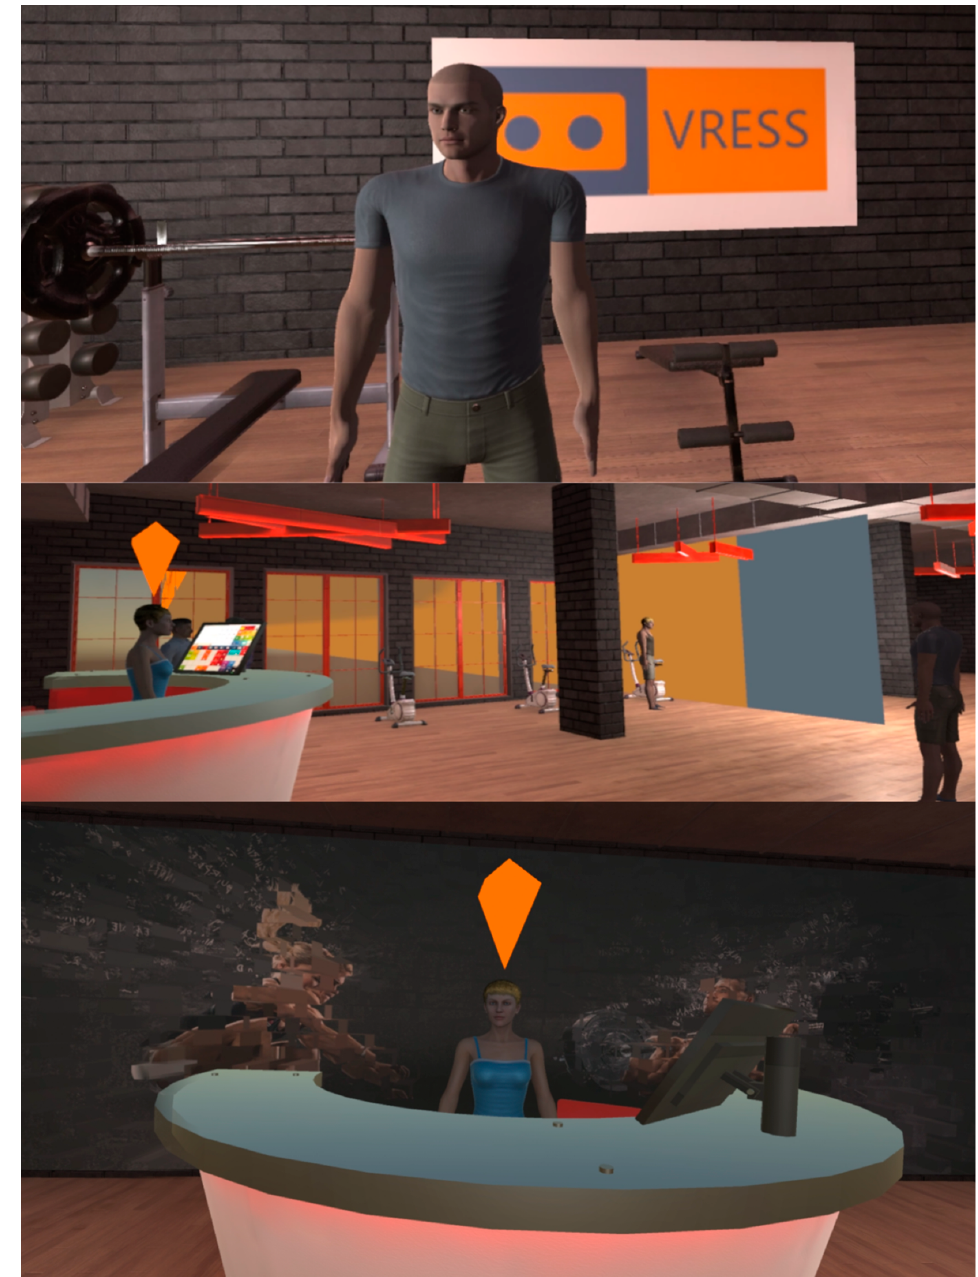
Figure 3. The instructor ( Top ), main area ( Middle ), and reception desk ( Bo tt om ) of the